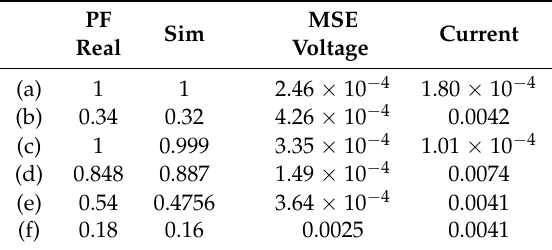
Table 14. Validation parameters (power factor (PF) and mean squared error (MSE)).